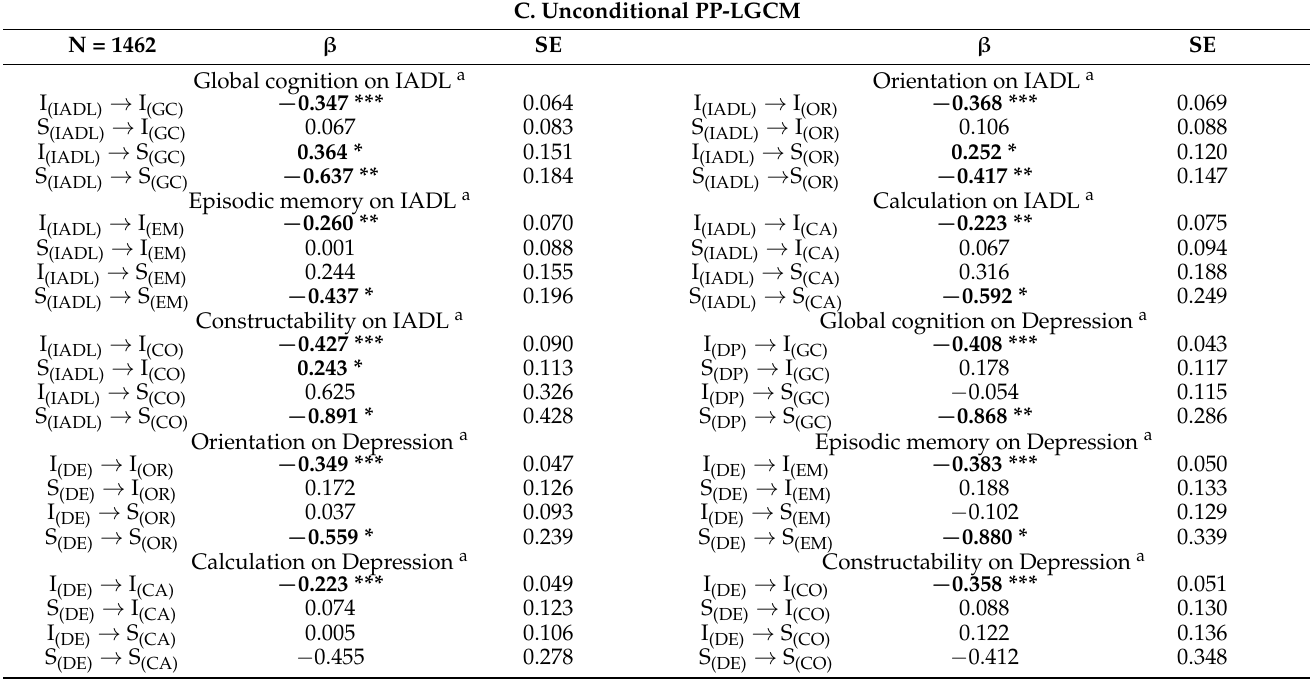
Table 3. Results of the unconditional Parallel Process curvilinear Latent Growth Curve Models